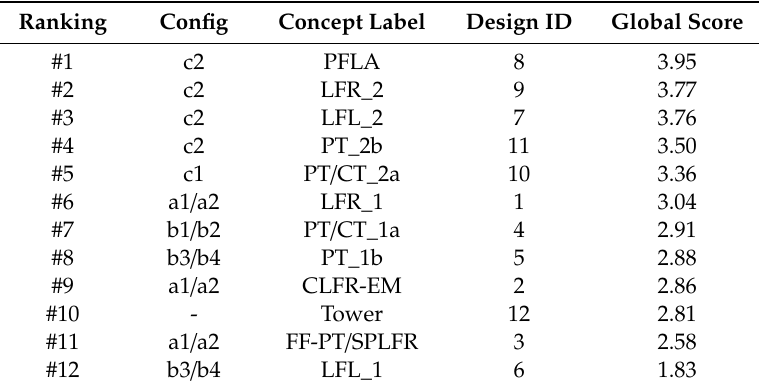
Figure 9. Global score for each design concept listed in Table 4. The contribution of each functional requirement is displayed in each stacked bar. Table 9. Ranking of solar concentrator design concepts.